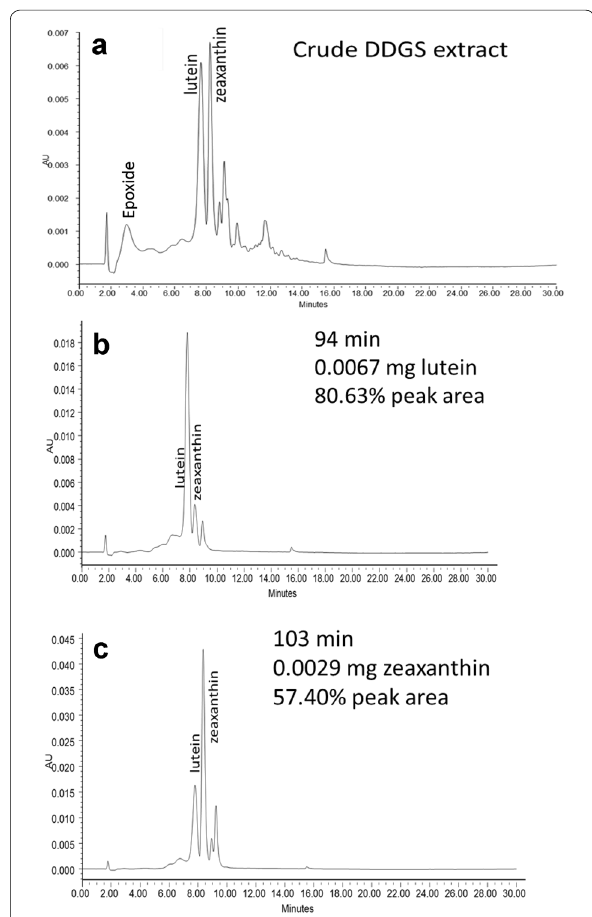
Fig. 3 HPLC analyses of the lutein and zeaxanthin peak from CPC trace: a displays the crude DDGS sample extract from Soxhlet extraction, in which the area % of lutein peak is 28.11% and zeaxanthin’s is 20.42%, b is minute 94 with L at 80.63% purity and Z at 10.91%, and c is minute 103 where Zeaxanthin had its maximum elution with peak area % at 57.40 and 19.19% for